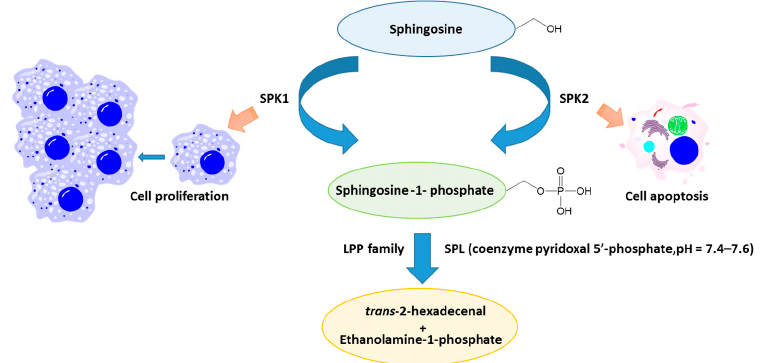
Figure 2. Involvement of S1P in cell apoptosis and cell proliferation. Divergent cellular effect via sphingosine kinase isoform activation. Increasing of cellular proliferation and migration by growth factors and cytokines depend on SPK1 activation and promotion of apoptosis by activation of SPK2. Elimination of S1P via different ways: dephosphorylation reactions catalyzed by S1P-specific phosphatases that require the coenzyme pyridoxal 5 (cid:48) -phosphate and a specific pH range (7.4–7.6) or by enzymes belonging to the nonspecific lipid phosphate phosphatase family (LPPs) which are important in controlling local S1P levels within specific tissue niches. Abbreviations: SPK1—sphingosine kinase